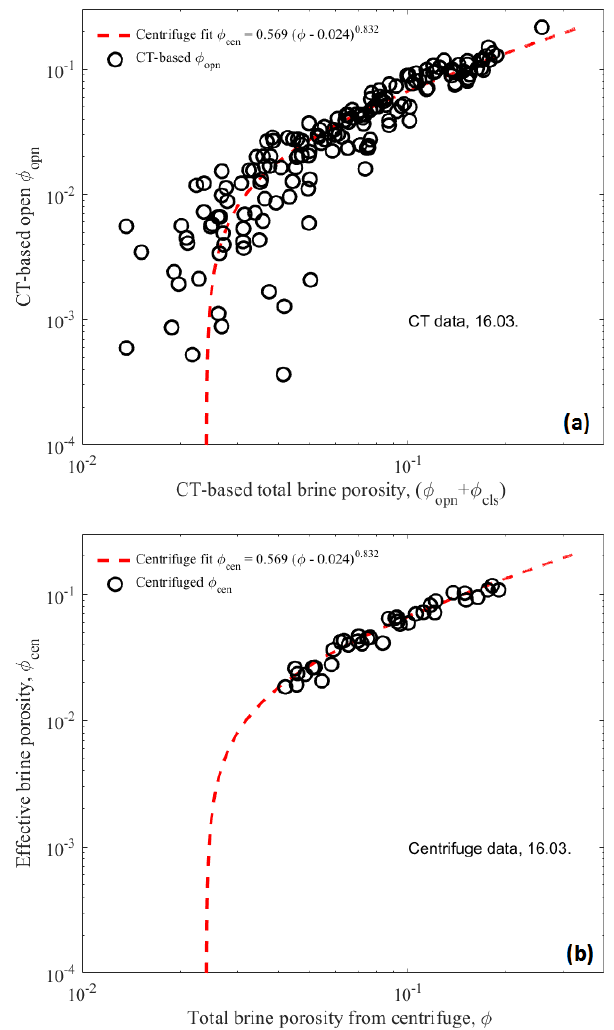
Figure 6. (a) Relationship between CT-based open brine porosity φ opn and CT-based total brine porosity (φ opn + φ cls ) , shown as cir- cles, in comparison to the centrifuge-based effective porosity fit (dashed red curves). (b) The relationship between φ cen and φ for the same ice core samples (a 5-core subset of the 15 ice cores in Fig. 4a). Note that (a) shows results for sub-samples of the samples in (b)